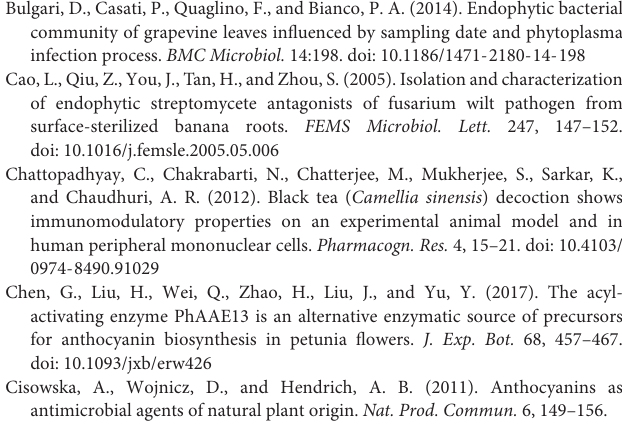
FIGURE S1 | DNA gel electrophoresis of PKS-I , PKS-II , and NRPS . The PCR amplification products were resolved using electrophoresis in 1.5% agarose